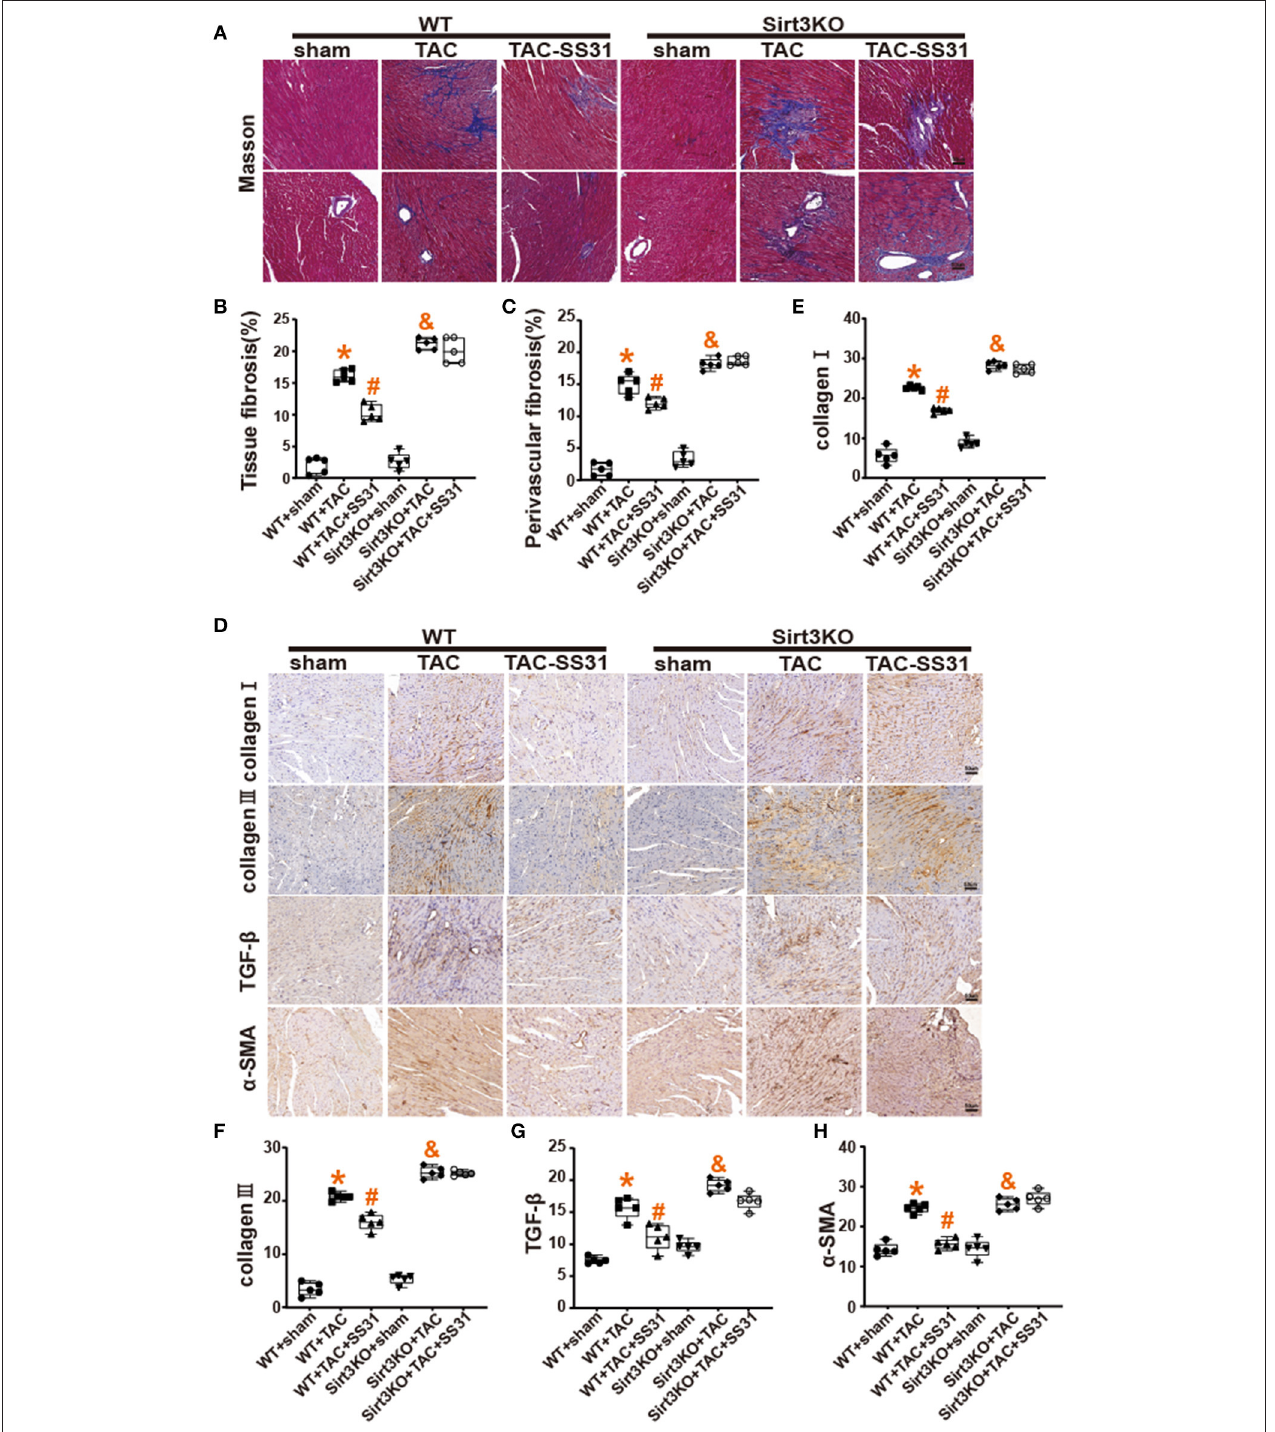
FIGURE 2 | The effect of SS31 on myocardial fibrosis in mice. (A) Masson staining images of each group; (B) Masson staining statistical analysis of the degree of fibrosis between tissues; (C) Masson staining statistical analysis of the degree of perivascular fibrosis ( n = 5, * p < 0.05, WT + TAC vs. WT + sham; # p < 0.05, WT + TAC + SS31 vs. WT + TAC; & p < 0.05, Sirt3KO + TAC vs. Sirt3KO + sham); (D) Immunohistochemical staining images of collagen I, collagen III, TGF- β and α -SMA in each group (bar = 20 µ m); (E–H) collagen I and collagen III immunohistochemical staining statistical analysis. (The results are expressed as the means ± SEM, n = 5. The one-way ANOVA test was used, and n represents the number of independent experiments. * p < 0.05 vs. WT + sham group; # p < 0.05 vs. WT + TAC group; & p < 0.05 vs. Sirt3KO + sham